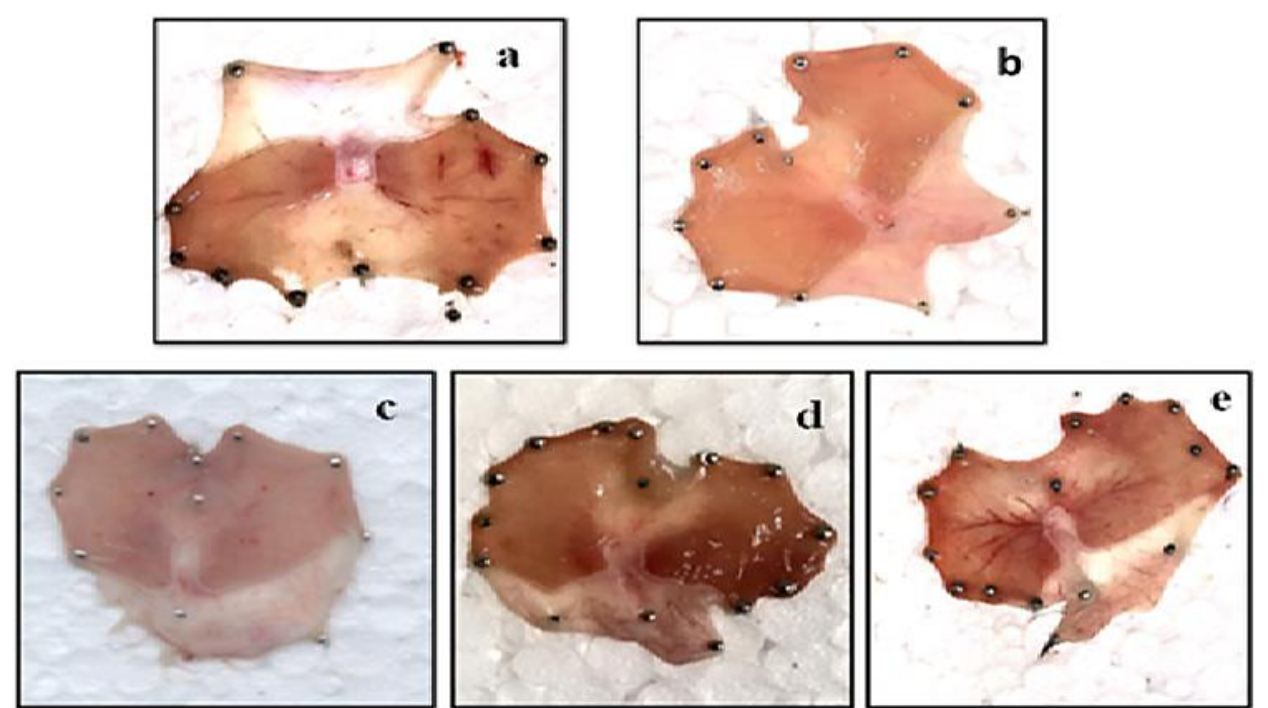
Figure 3. Macroscopic observation of gastric mucosal lesions in the ulcer model; ( a ) Indomethacin (21 mg/kg); ( b ) control; ( c ) SA-4 (12 mg/Kg); ( d ) SA-4 (24 mg/kg); ( e ) SA-1 (24 mg/Kg).